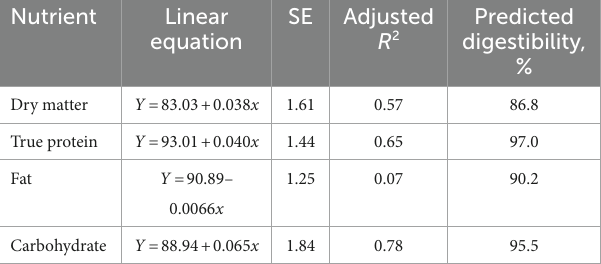
TABLE 6 Prediction of apparent macronutrient digestibility of 100% rice protein concentrate.